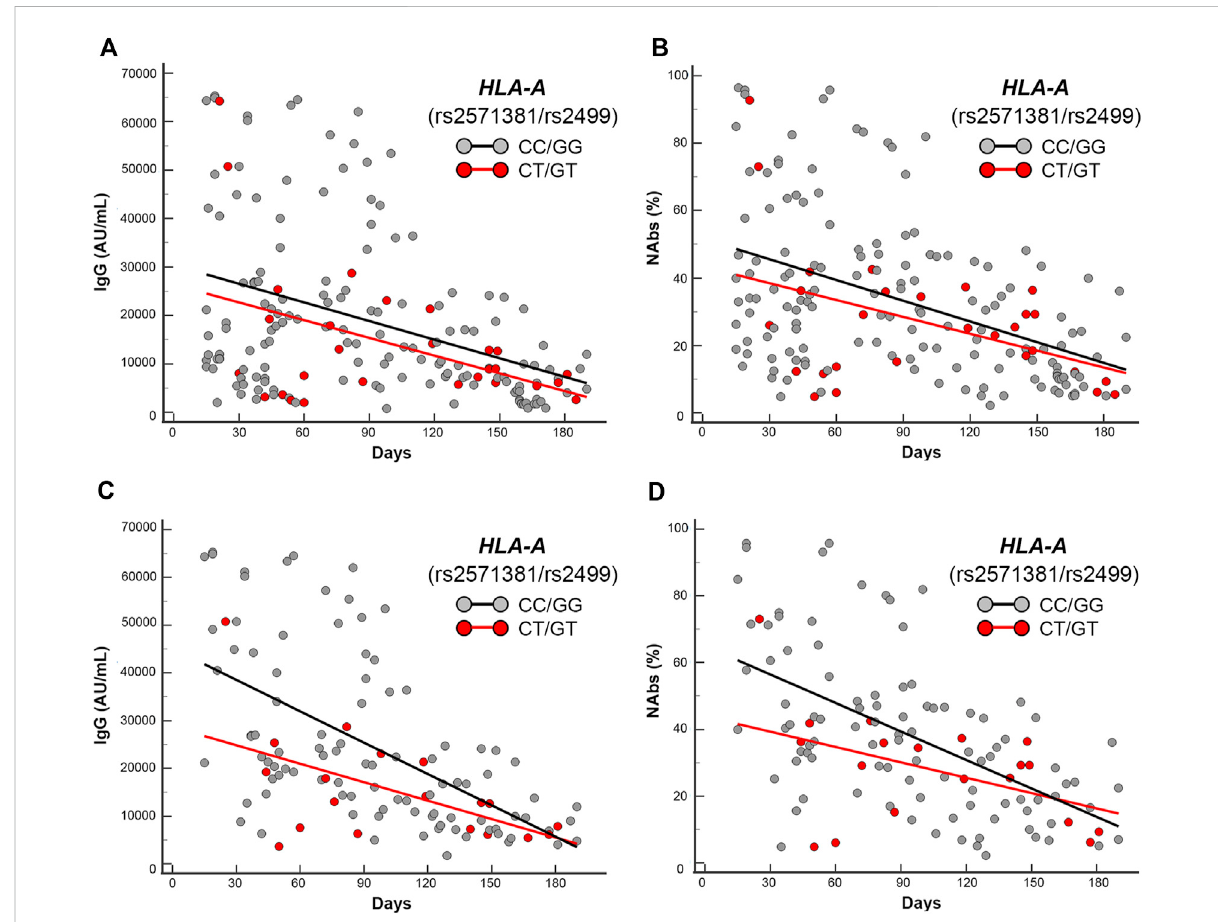
FIGURE 5 Scatter plots and regression analyses of IgG and NAbs levels strati fi ed by HLA-A (rs2571381/rs2499). (A,C) IgG and (B,D) NAbs kinetics in the whole cohort (A,B) and in the mRNA-based vaccine subgroup (C,D) . Each panel shows the speci fi c regression lines according to the indicated